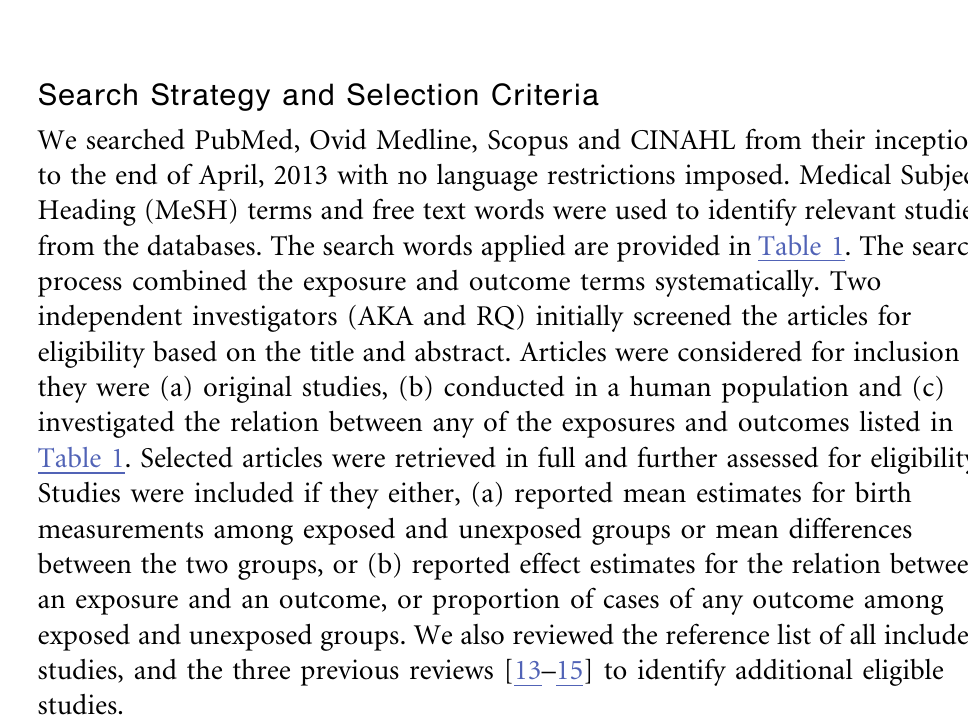
We searched PubMed, Ovid Medline, Scopus and CINAHL from their inception to the end of April, 2013 with no language restrictions imposed. Medical Subject Heading (MeSH) terms and free text words were used to identify relevant studies